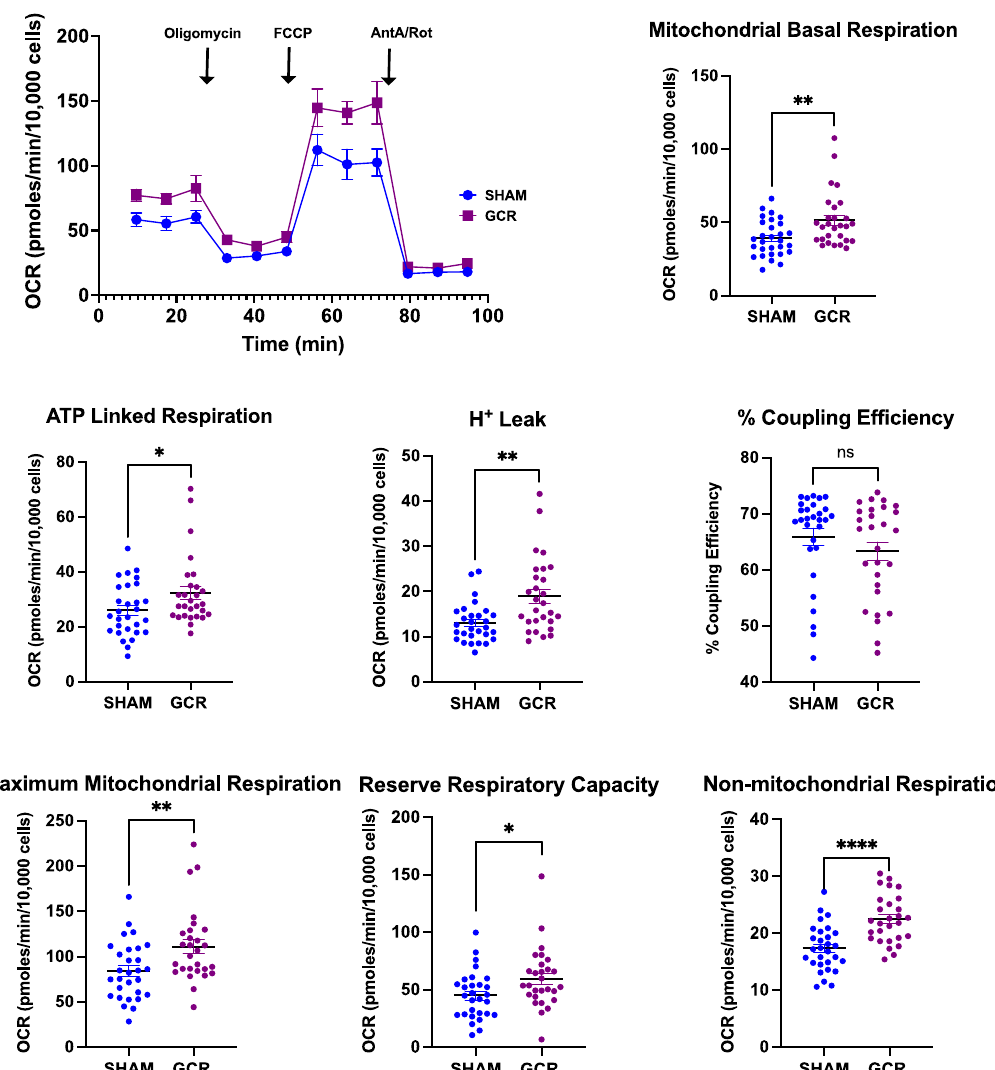
Figure 7. GCR exposure increases overall mitochondrial and non-mitochondrial respiration. Bone marrow macrophages were isolated from 9-month-old male BalbC sham or GCR exposed mice 3 months after the mice were irradiated and cultured with M-CSF (30 ng/mL) and RANKL (30 ng/mL) for 3 days. Seahorse extracellular Flux analysis revealed moderate but significant increases in basal mitochondrial and non-mitochondrial respiration in pOCs isolated from GCR exposed mice. ATP-linked respiration and maximum mitochondrial oxygen consumption were also significantly increased in the GCR group compared to the sham irradiated group. Although there was an increase in proton leak in pOCs isolated from GCR exposed mice, no differences were detected in coupling efficiency between the groups. Data are presented as ± SD. p values were determined using Student’s t -test. (n = 28–30 wells, * p < 0.05, ** p < 0.01, **** p < 0.0001).